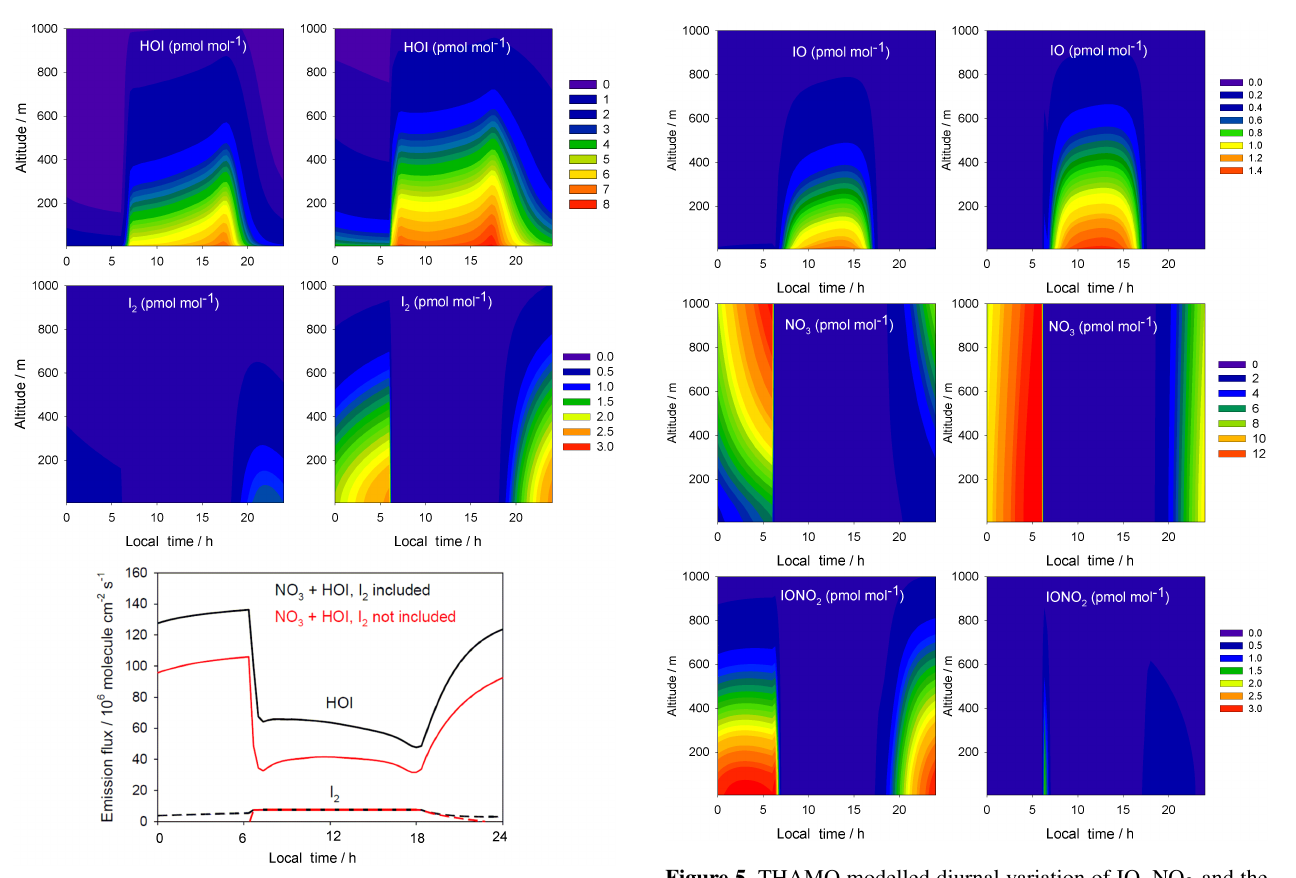
Figure 4. THAMO modelled diurnal variation of HOI, I 2 (upper panels) and the HOI / I 2 flux from the ocean surface (bottom panel). The right-hand panels are from Scenario 1, which do not include nighttime reactions of HOI and I 2 with NO 3 , while the left-hand panels include the reactions in Scenario 2. In bottom panel red lines represent Scenario 1, while black lines correspond to Scenario 2.